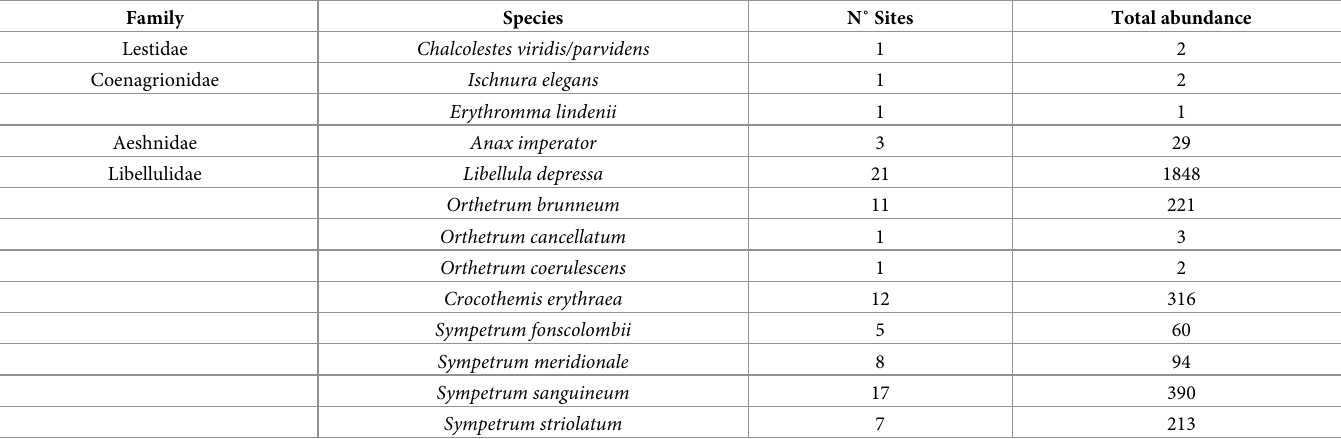
Table 2. Species checklist, number of sites where they have been found, and total abundance (number of individuals for each species). Family